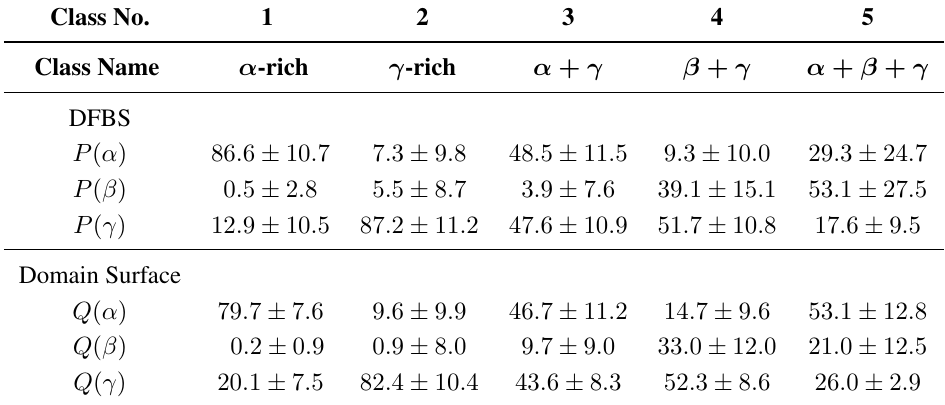
Table 2. The Mean and SD (percent units) of the SSE propensities for the five defined DFBS